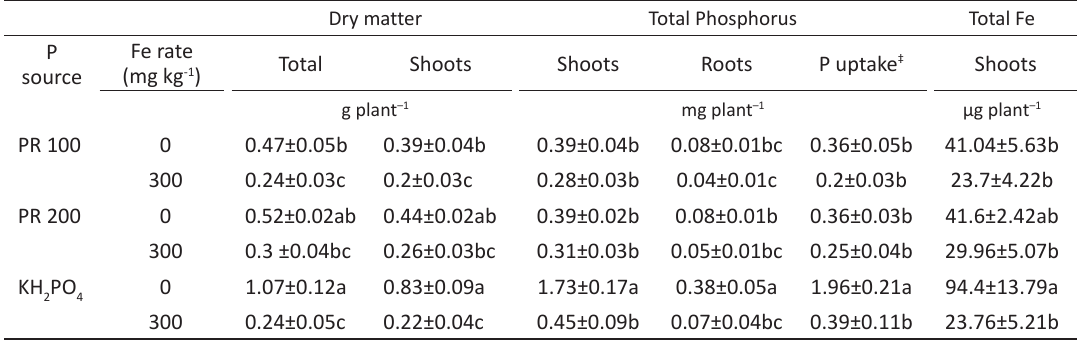
Mean ± standard error, n = 10; PR = phosphate rock; ‡ = estimated as the total P in aerial parts and roots minus P present in seeds Means followed by a different lowercase letter in a column were significantly different according to Tukey’s test at a p < 0.05 (for combinations of treatments)